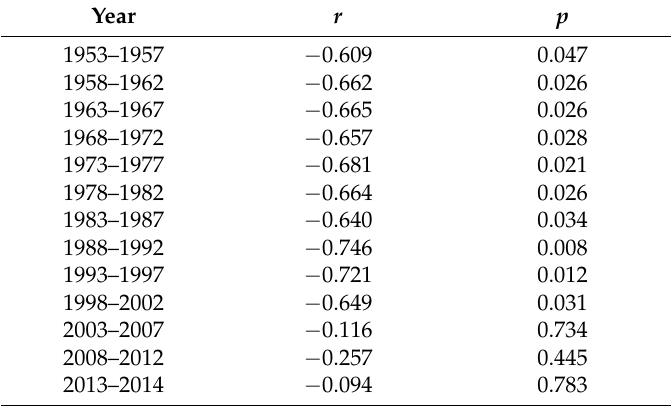
Table 1. Correlation between the annual incidence of typhoid and paratyphoid and altitude in Zhejiang Province from 1953 to 2014.